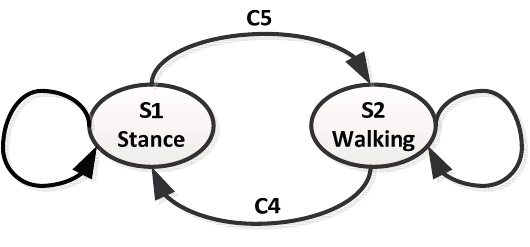
Figure 5. Finite state machine (FSM) for coping with carrying modes transformation during actual